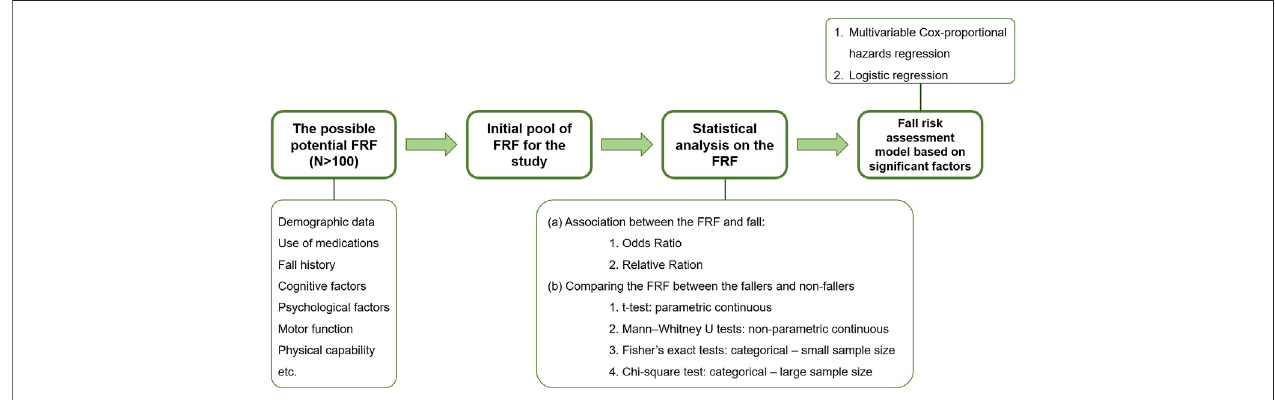
FIGURE 2 | The general path of fall risk assessment studies in stroke survivors with a focus on implemented statistical analysis methods.